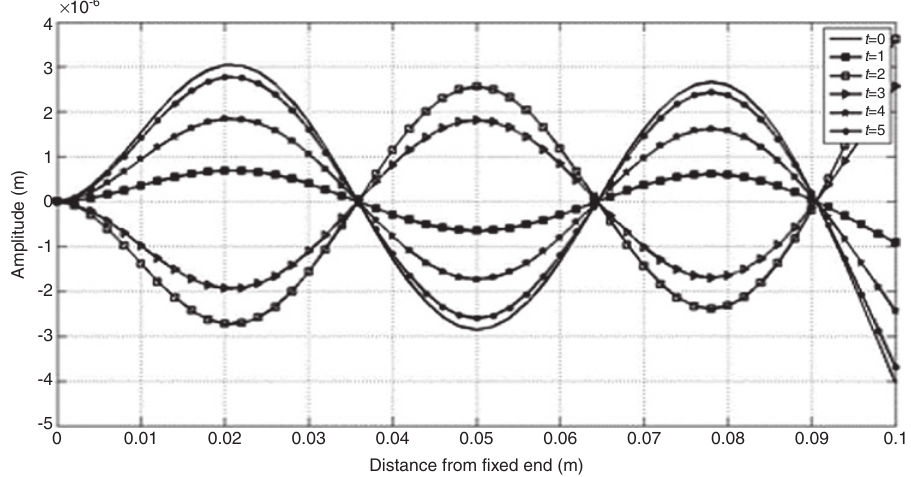
Figure 12: Vibrations of the fourth characteristic mode of the cantilever beam. Time, t , is in milliseconds.